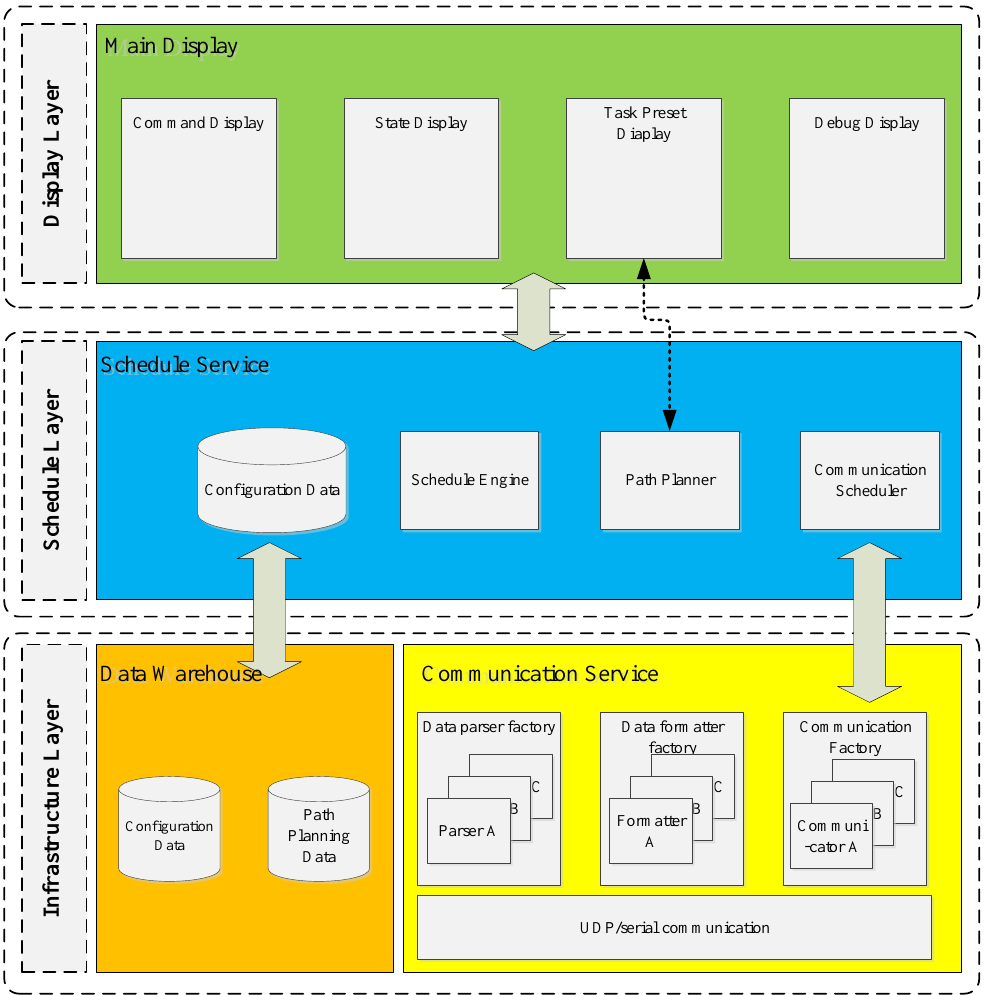
Figure 4 . Architecture of factory method-based monitor software. Figure 4. Architecture of factory method-based monitor